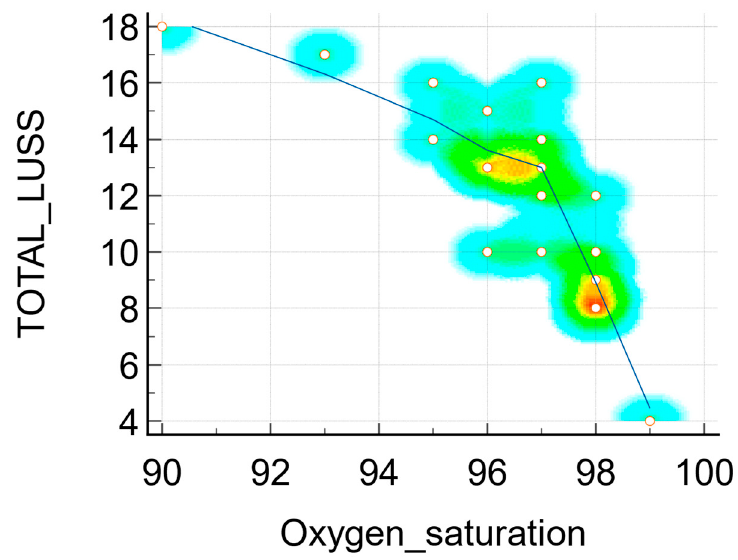
Figure 7. Scatter diagram with a heat map of correlation between LUSS and O 2 saturation.